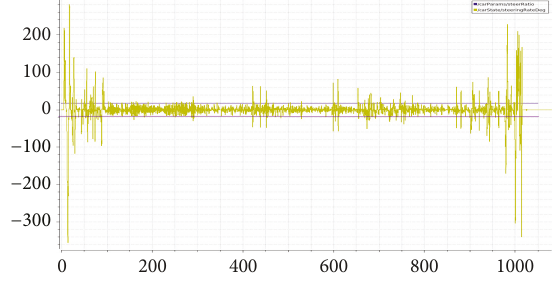
Figure 24: T1D5 steering degrees.